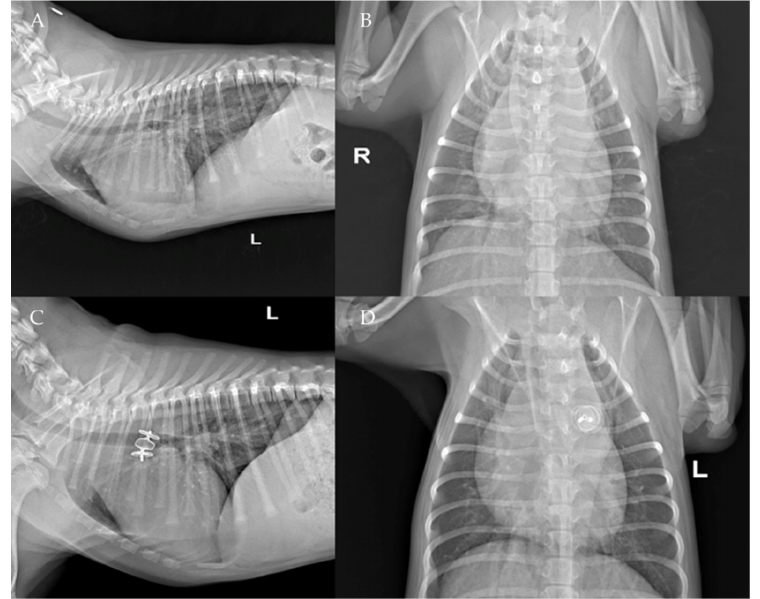
Figure 8. Pre-procedure ( A , B ) and post-procedure ( C , D ) left lateral and dorso-ventral thoracic radiographs of Case 1. L: left; R: right.